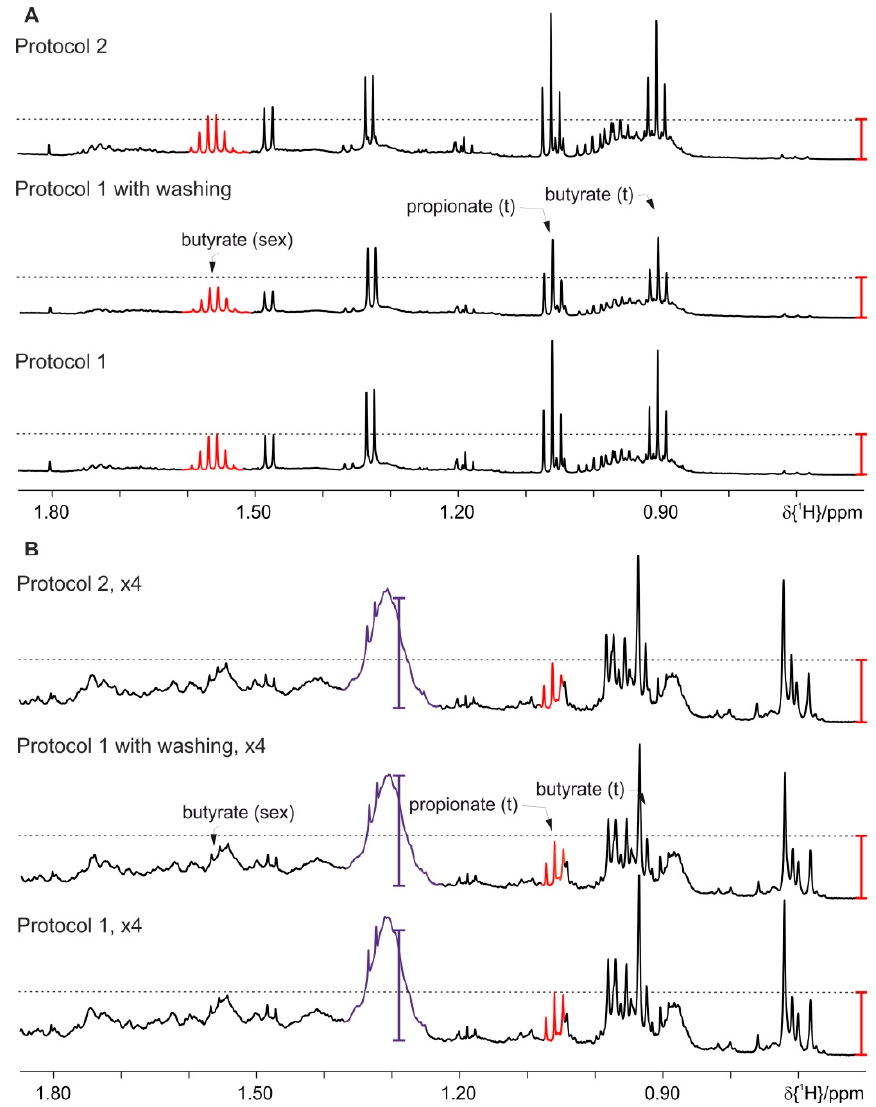
Figure 8. Effect of optimized lipid extraction at 4 °C on the concentration of metabolites and amounts of background signals using Protocol 1 without and with washing steps and Protocol 2: ( A ) feces of mice fed on a standard diet and ( B ) on HFD (the intensity is upscaled four times). For clarity only a selected spectral range of the proton NMR spectra is shown. The red and violet bars are fixed at the same height in each section of the figure and indicate the increased signal intensities of the SCFA and background signals, respectively.